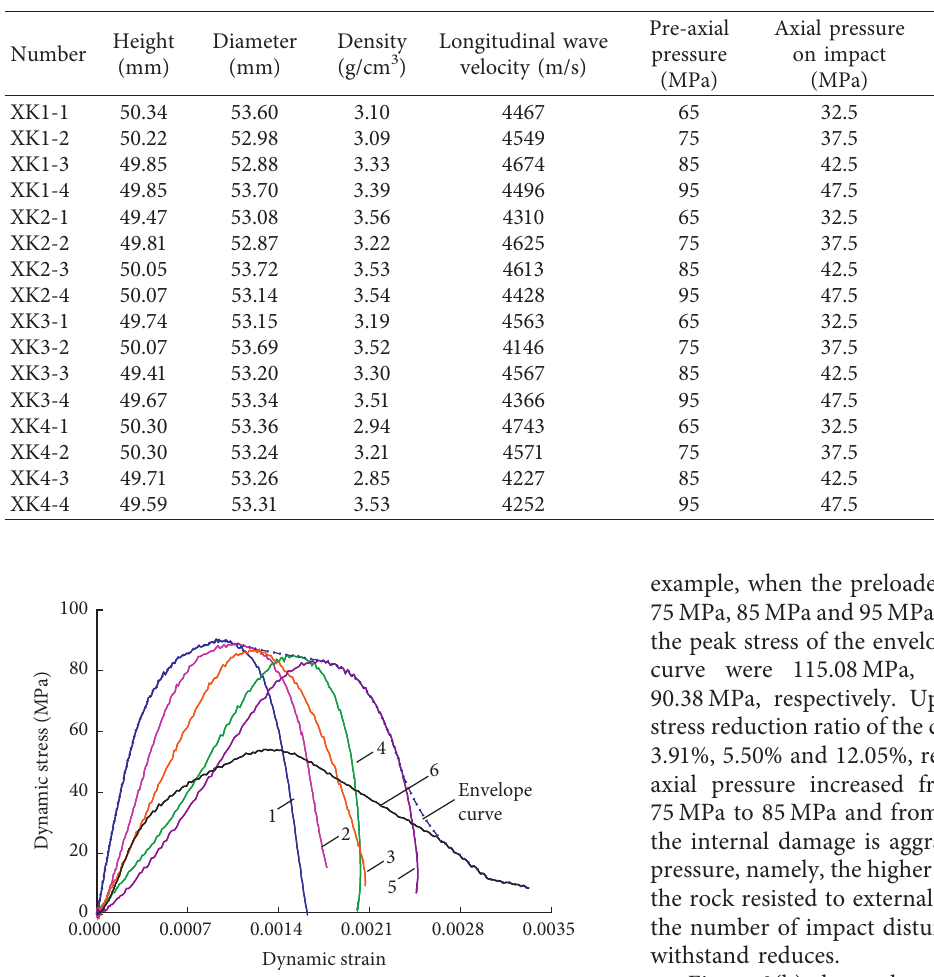
Table 2: Test scheme of high static stress unloaded and frequent disturbances.